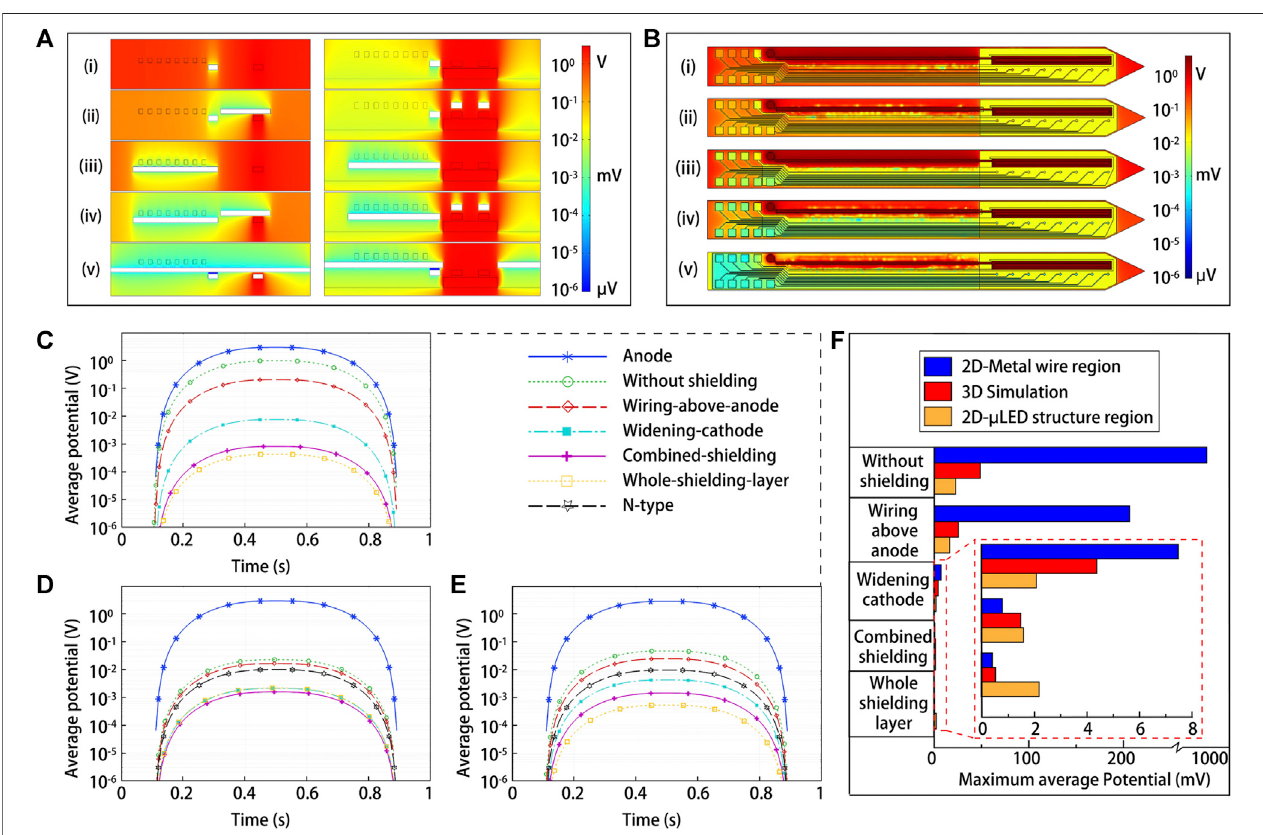
FIGURE3|(A) The2D potential distribution ofthemetal-wire region (left) andthe μ LED-structureregion (right) inelectrostatic fi eldsimulation. (B) Thetopviewof 3Dpotentialdistributionresultsinelectrostatic fi eldsimulation. (C – E) Thetime-domaincurvesofdifferentshieldingmethodsthatre fl ecttheeightelectrodesites ’ average potentialovertimein (C) metalwireregionsimulation, (D) μ LEDstructureregionsimulation,and (E) 3Dsimulation. (F) Thecomparisonofthemaximumaveragepotential between 2D and 3D time-domain simulation results.